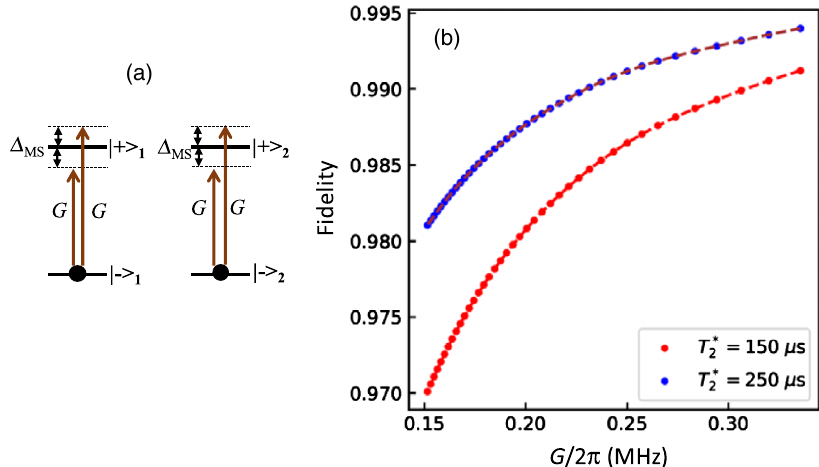
FIG. 7. (a) Schematic of the coupling scheme for the Mølmer-Sørensen gate between two single spins initially in state j − − i . (b) Fidelity of the Mølmer-Sørensen gate at T ¼ 0 . 5 K as a function of G , with the mechanical modes initially in a thermal state. Other parameters used are discussed in the text. The dashes lines are a guide to the